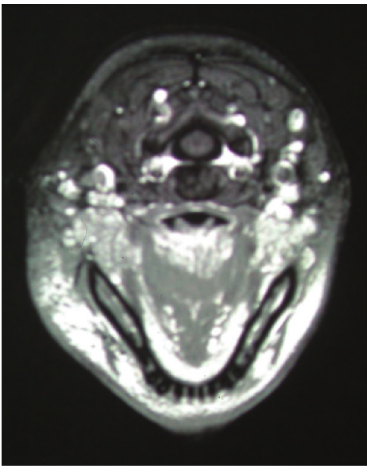
Figure 2: CT of the left parotid